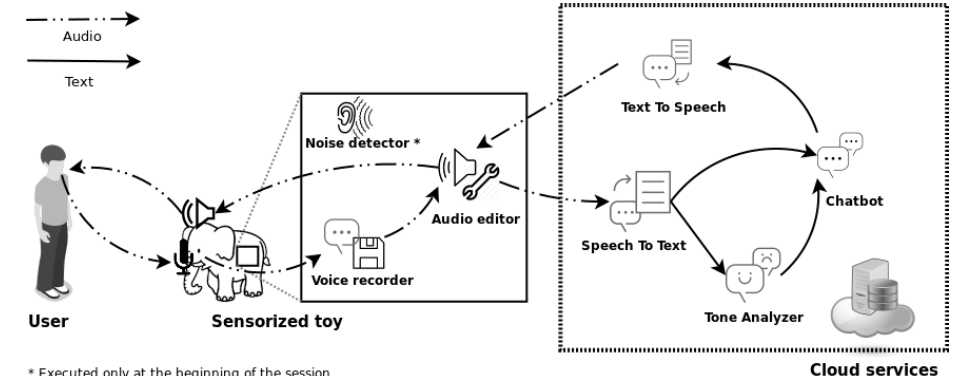
Figure 3. General view of MAmIoTie system including implemented services (Noise detector, Voice recorder and Audio Editor) and cognitive cloud services from IBM